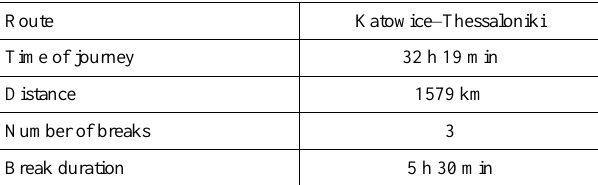
Table 6. Route details generated for Tesla Model 3 Long Range [7]